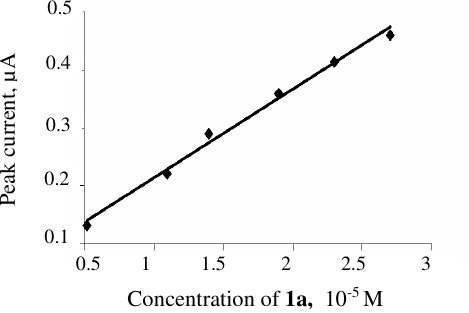
Figure 8. Differential pulse polarographic calibration plot of 1a in neutral buffers (pH = 6.5) on SMDE (6.25 x 10 -6 m 2 ) at 5 mVs -1 and a pulse height of 50 mV with KCl (0.05